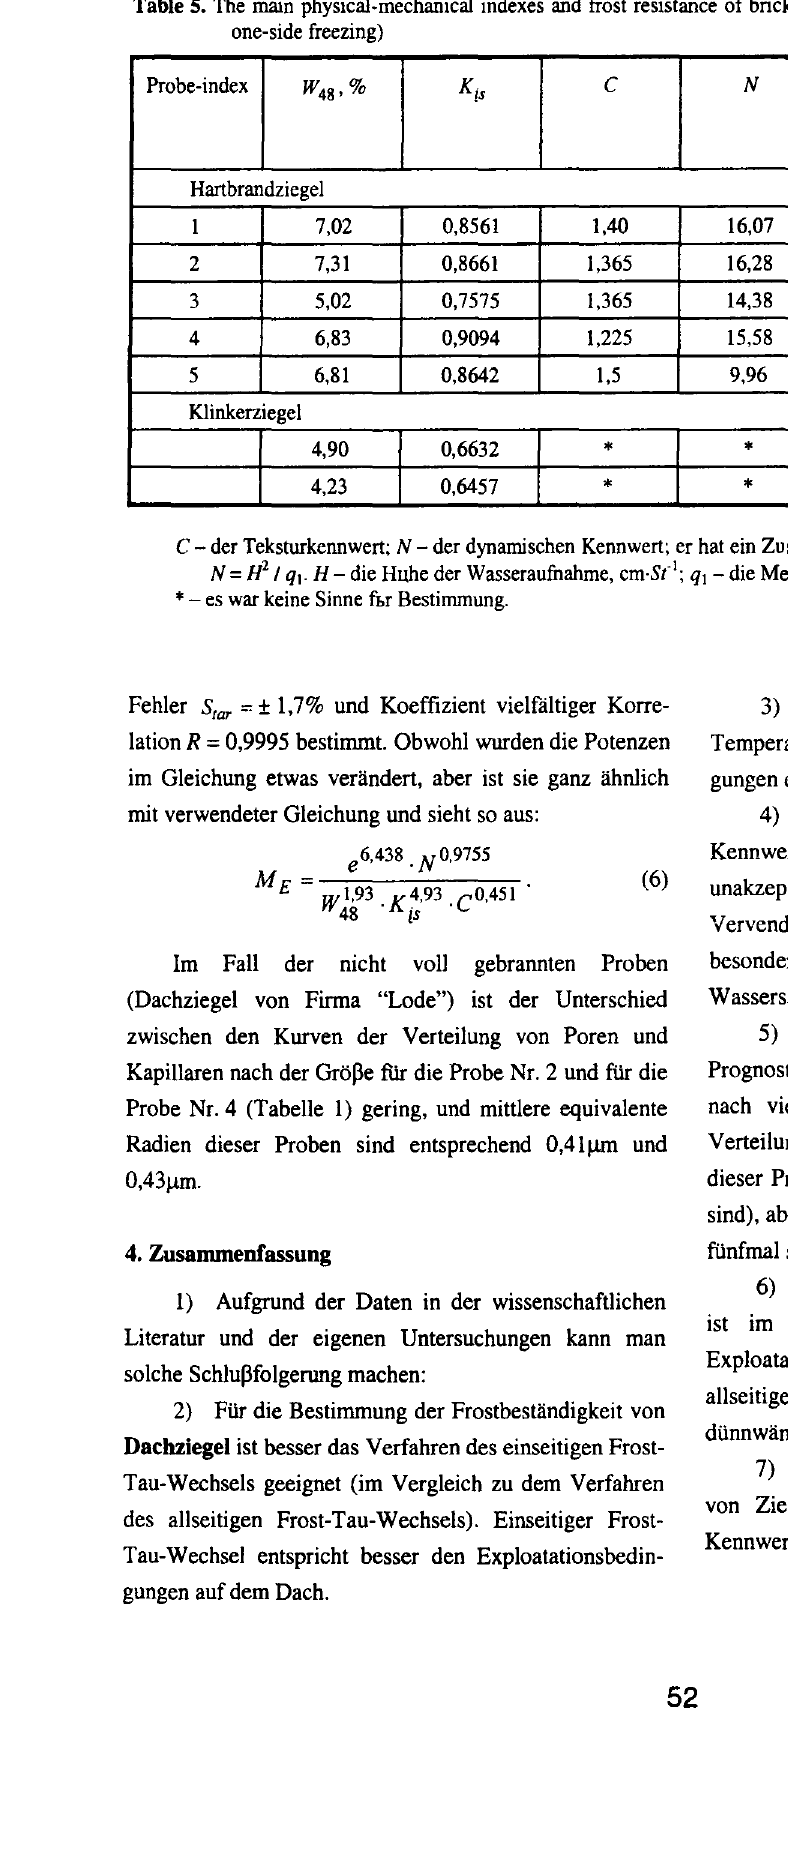
Table 5. The main physical-mechanical indexes and frost resistance of bricks (calculated cycles and real frost resistance under the one-side